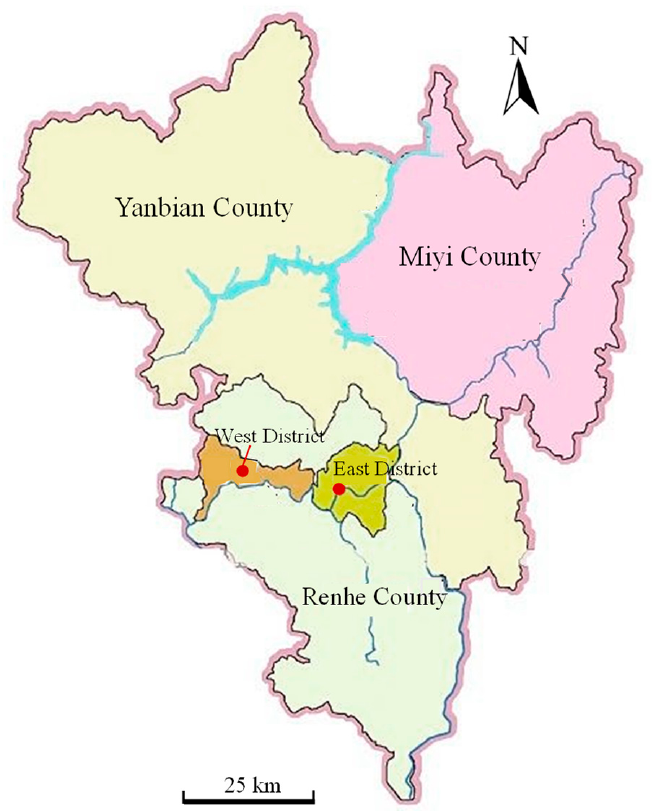
Figure 2. Map of Panzhihua City.